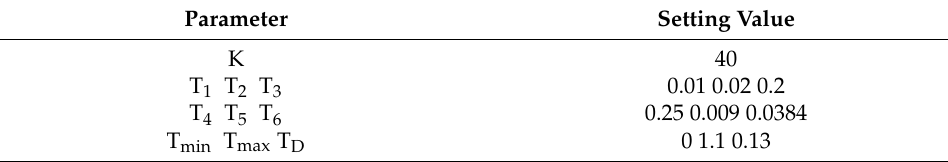
Table A3. Governor system.